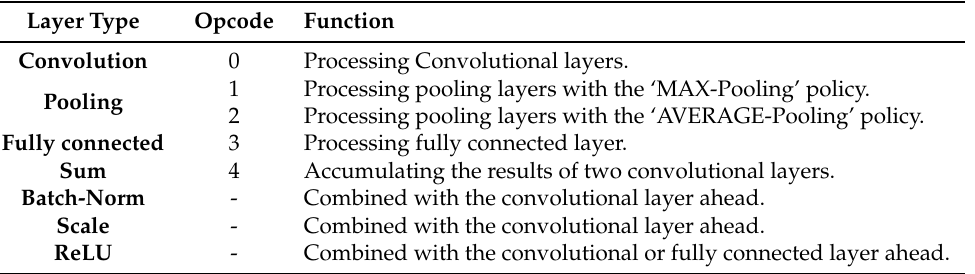
Table 1. Macro-instructions list.